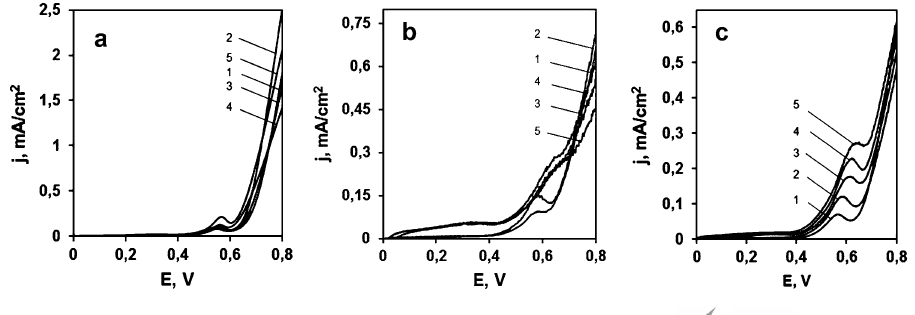
Fig. 5 Linear sweep voltammetry of Co 3 O 4 films deposited from nitrate ( a ), acetate ( b ) and chloride ( c )